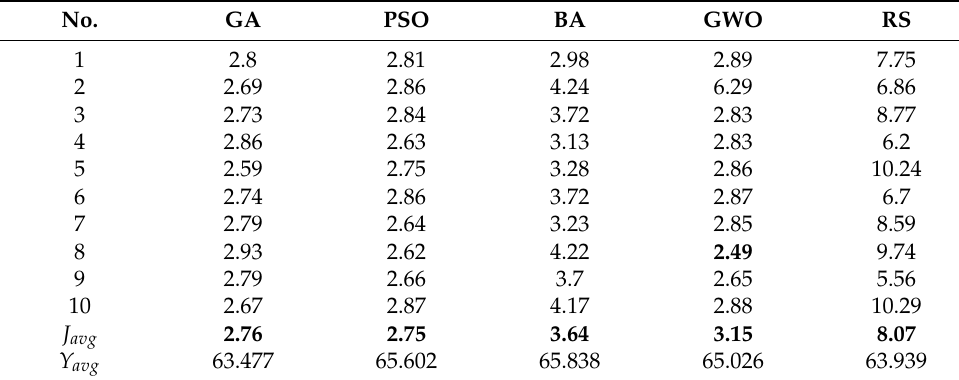
Table 2. The results of experiments: synthesized control. No. GA